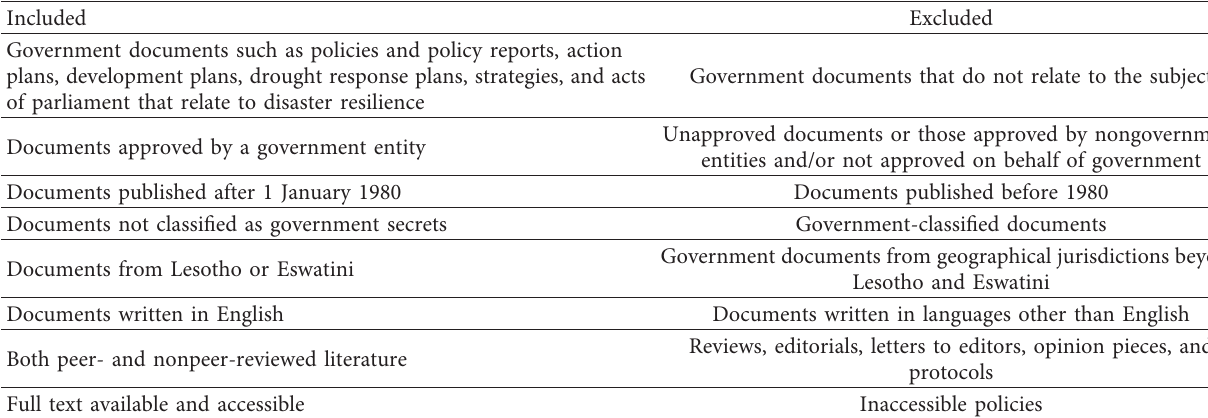
Table 2: Inclusion and exclusion